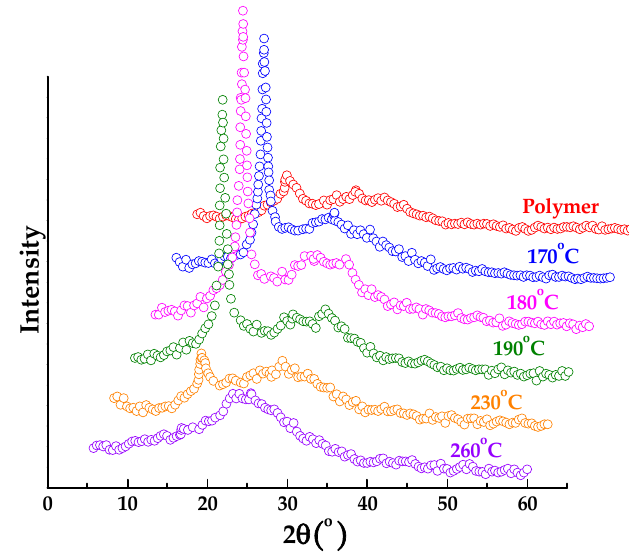
Figure 6. The XRD patterns of PAN membranes prepared at different cross-linking temperatures with the holding time of 1 h.